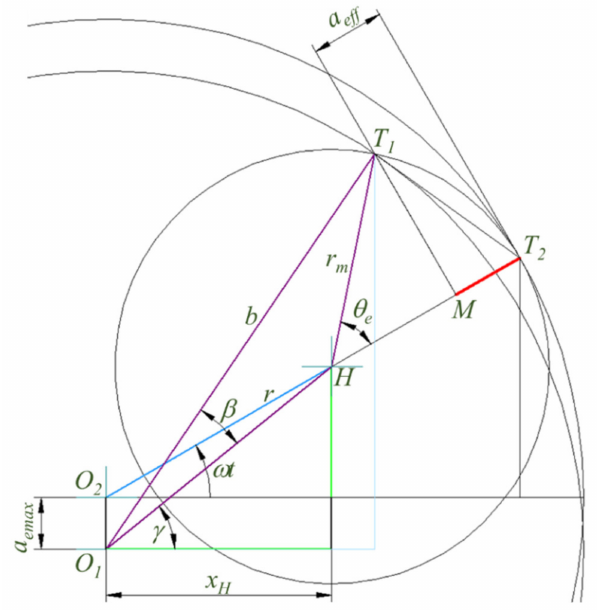
Figure 8. Obtaining the effective radial